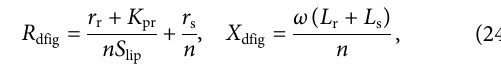
Frontiers in Energy Research |